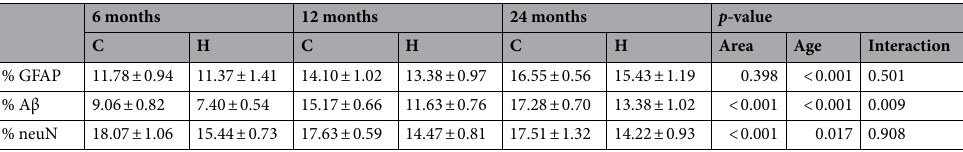
Table 1. Percentage of GFAP, Aβ, and neuN in different brain regions and at different postnatal ages, in AD Tg mice. Data are reported as mean ± SEM. p-values derived from a linear mixed model with brain region as the within variable and age as the between variable. C cortex, H hippocampus.